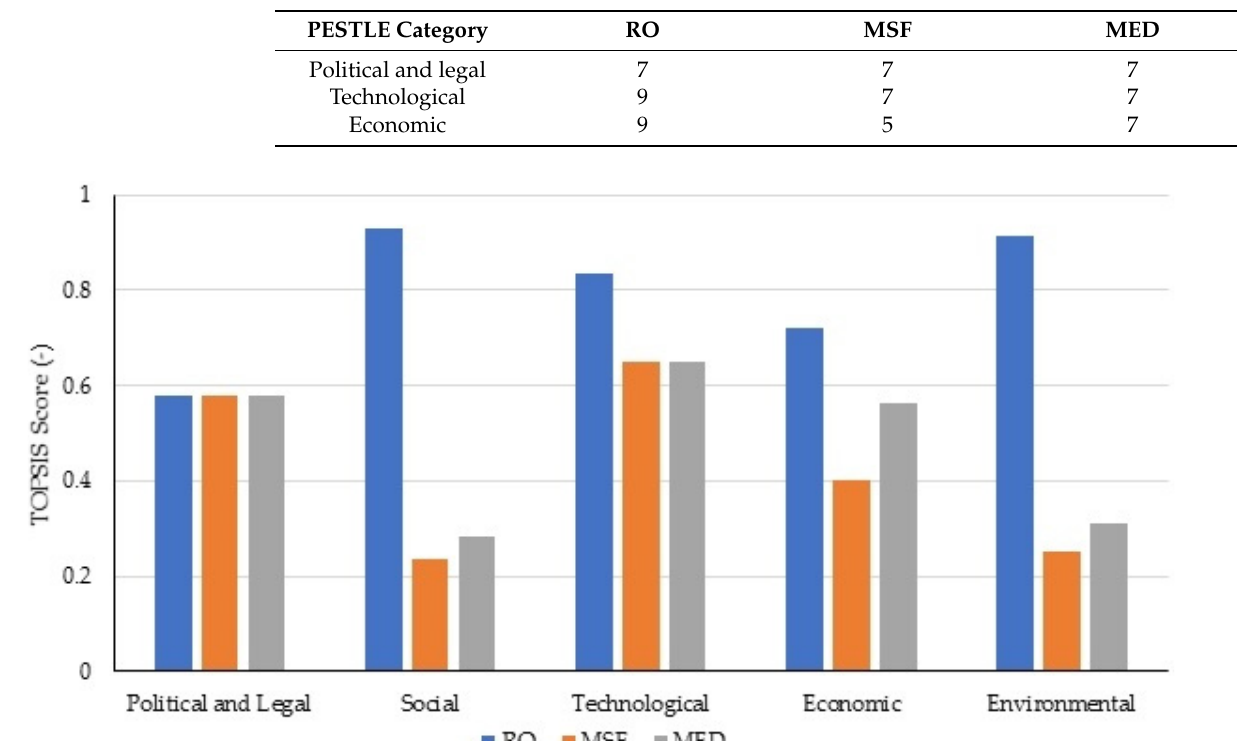
Table 15. The alternative ratings for the qualitative criterion in the case of the classical TOPSIS method. 1—poor; 3—medium poor; 5—fair; 7—medium good; 9—good; 2, 4, 6, 8—intermediate values in between.